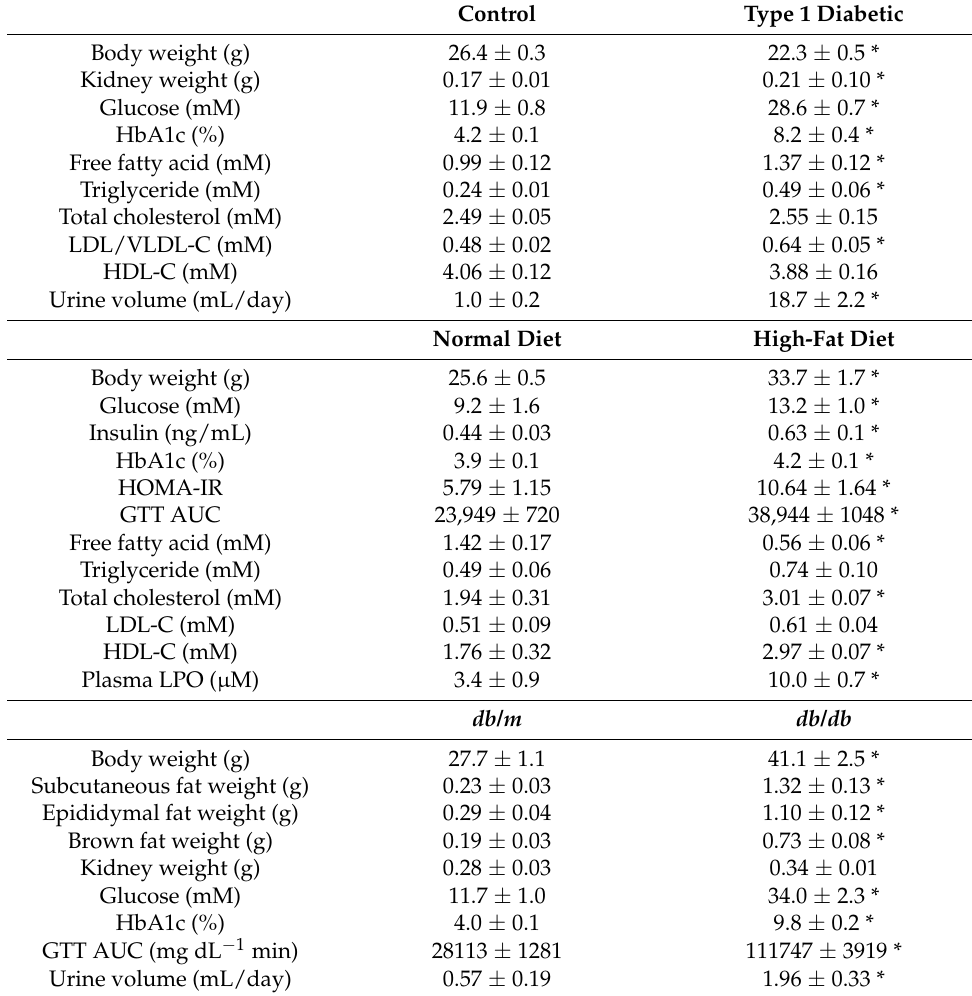
Table 1. General characteristics and biochemical profile of experimental